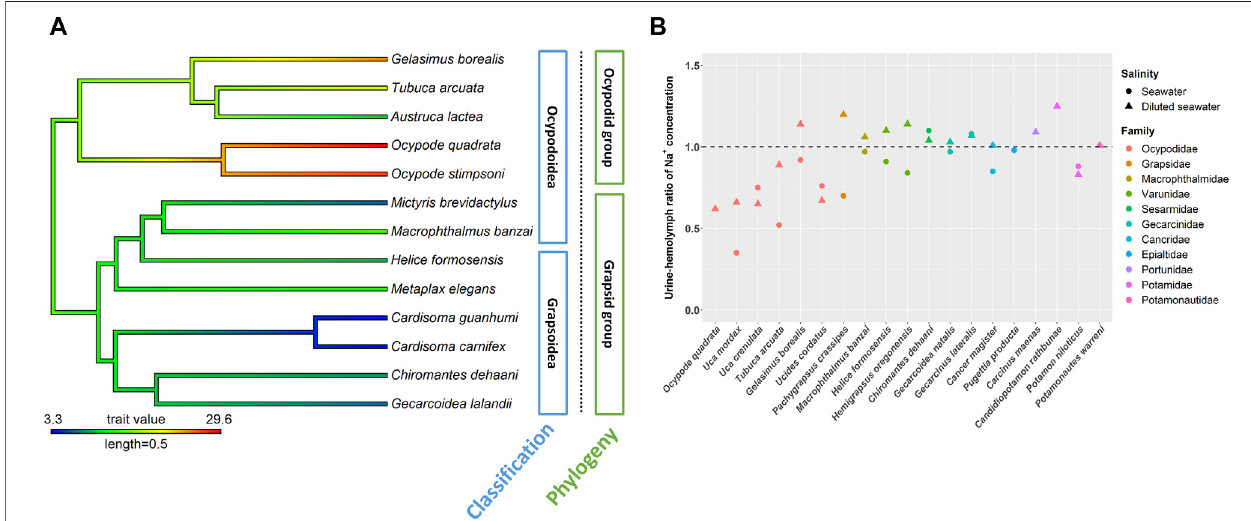
FIGURE2| TheNKA activity andurineand hemolymphratio(U/H) forNa + intheantennal glandsofdifferentcrab species. Thephylogenetictreewasgeneratedby Bayesian inference with COI and 16S rDNA. The antennal gland NKA activity of crabs in 5 ppt was mapped on the phylogenetic tree and the ancestor status was predicted by the phylogenetic structure. Labels in blue boxes were the superfamilies of brachyuran. Labels in green boxes were the groups separated by the clades in phylogenetic trees. (A) Antennal gland NKA activity in the ocypodid group was higher than that in the grapsid group. (B) Ocypodidae species had a lower U/H for Na + than did species in other families. The fi gure comes from Tseng et al.